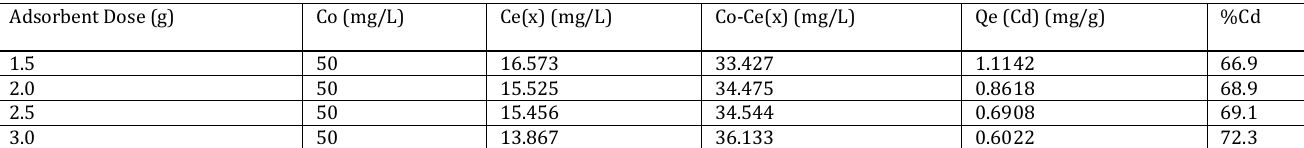
Table 5: Effect of adsorbent dose on the removal of Cd from aqueous solution